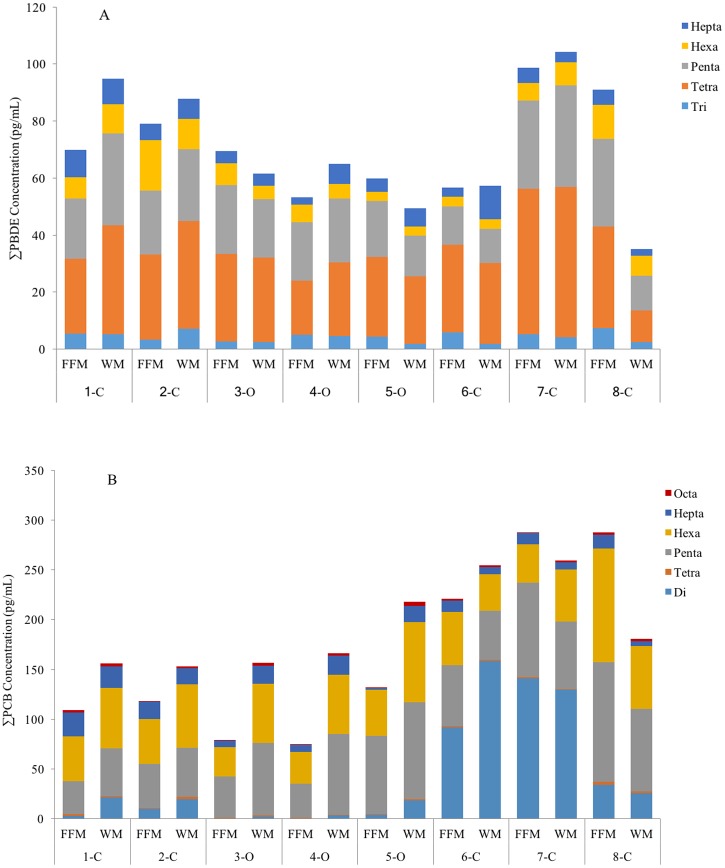
The concentrations of ∑PBDEs and ∑PCBs with the relative amount of chlorination and bromination.(A) ∑PBDEs (Tri: BDE-17 and -28, Tetra: BDE-47, -49 and -66; Penta: BDE-85, -95, -99 and -100; Hexa: BDE-153 and -154; Hepta: BDE-183). (B) ∑PCBs (Di: PCB-11; Tetra: PCB-77; Penta: PCB-84, -91, -95, -101 and -118; Hexa: PCB-131, -132, -135, -136, -138, -149 and -153; Hepta: PCB-174, -175, -176 and -180; Octa: PCB-196). Number 1 to 8 represent eight different brands of commercial milk. ‘C’ indicates conventional milk, while ‘O’ indicates organic milk. Data shown are the geometric mean (pg/mL).